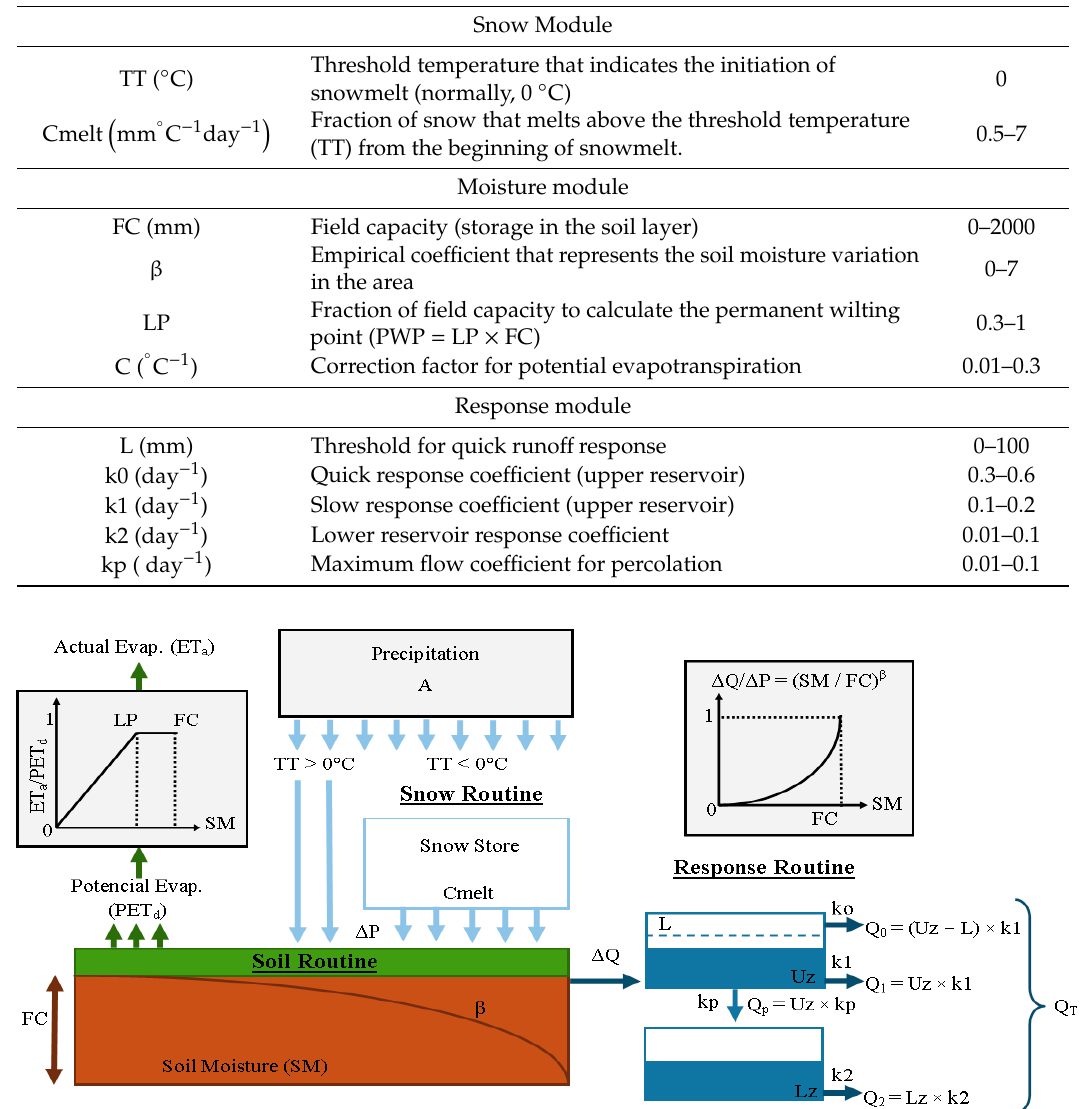
Figure 3. Conceptual diagram of the Hydrologiska Byråns Vattenbalansavdelning (HBV) model [47].